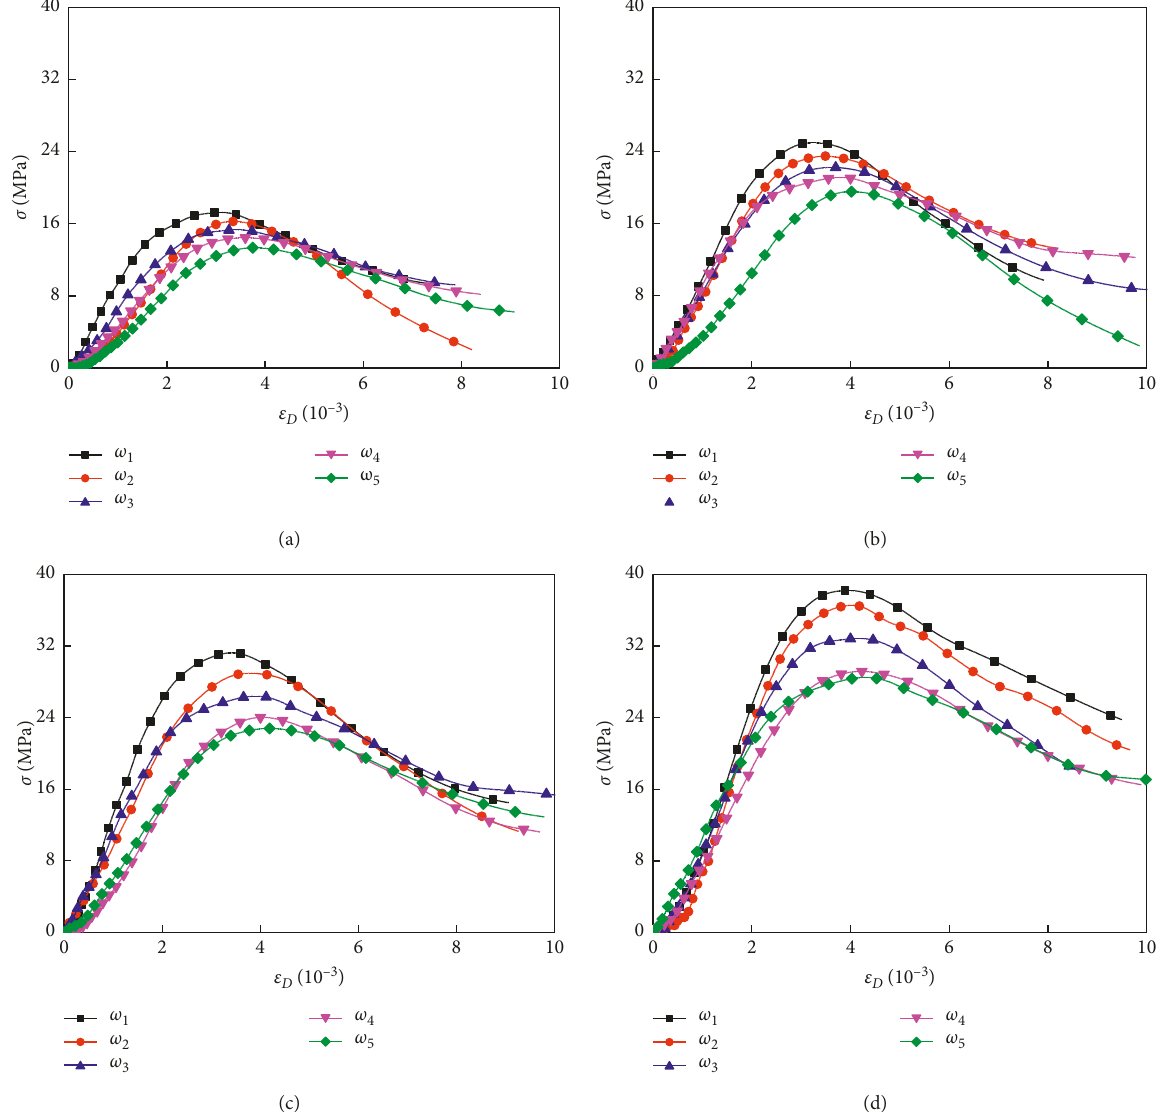
Figure 4: Stress-strain curves of sandstone specimens with different water contents: at a strain rate of (a) 53.04s − 1 , (b) 73.16 s − 1 , (c) 89.04s − 1 , and (d) 104.87s − 1